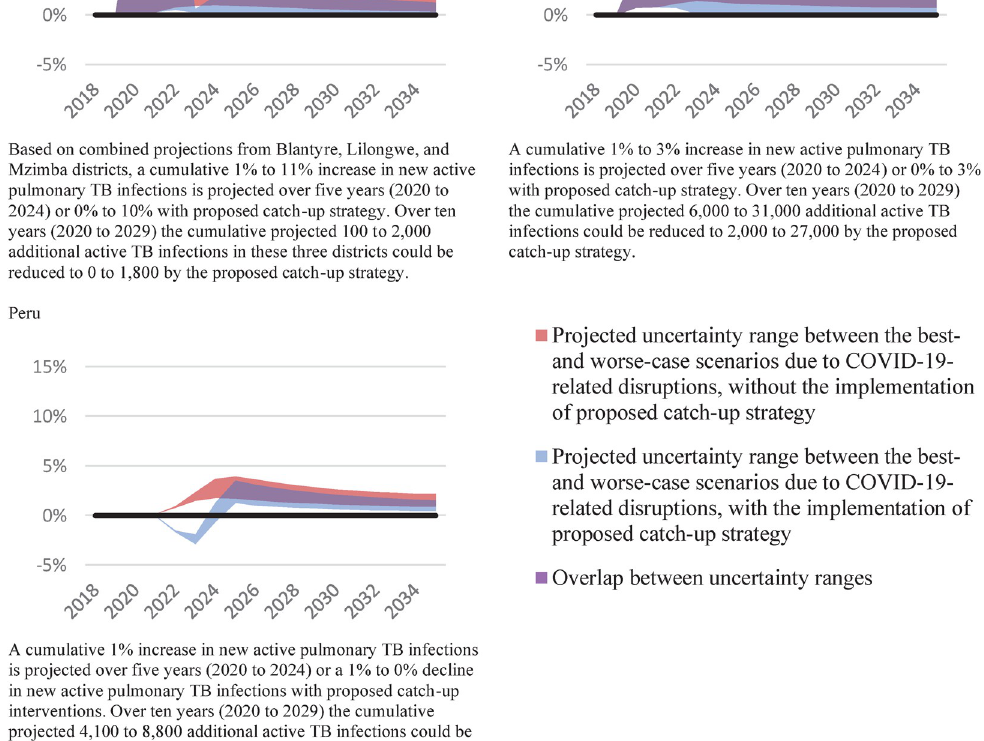
Fig 3. Impact on new active pulmonary TB infections (excluding relapse), relative difference to the status quo counterfactual, 2018–2035.